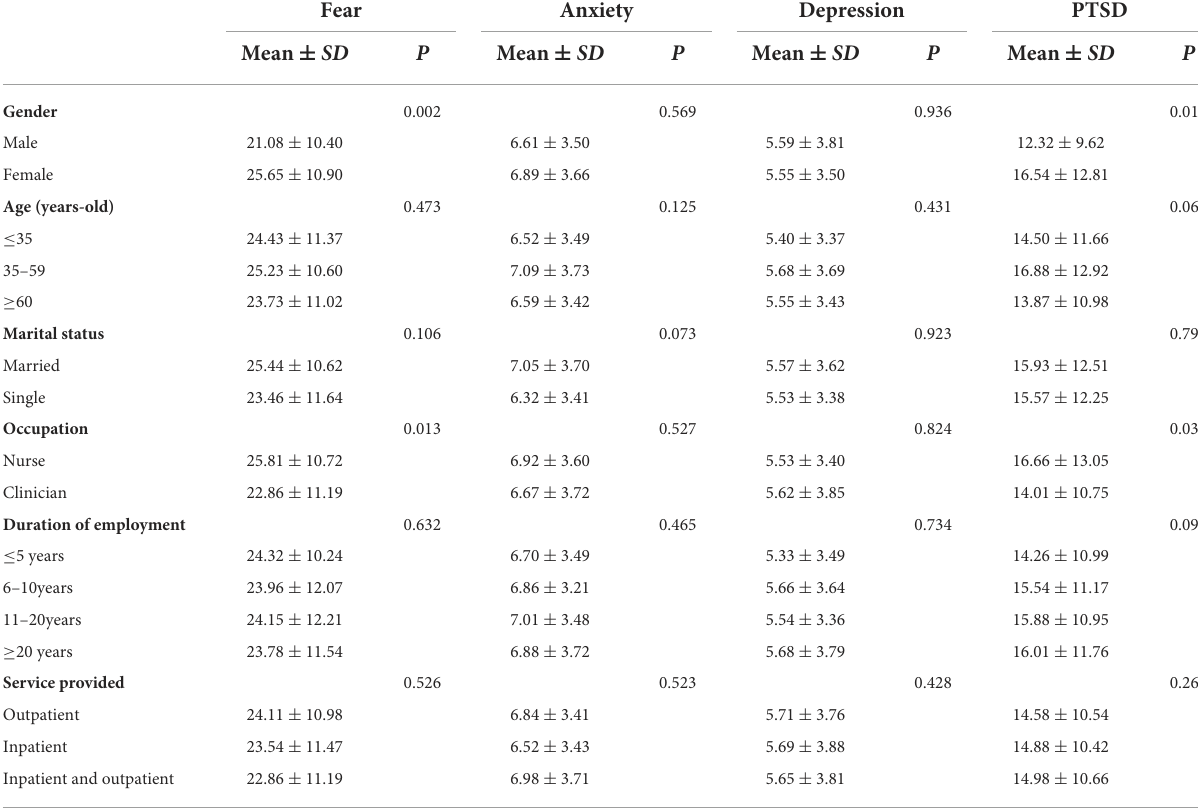
TABLE 3 Association between fear, anxiety, depression, PTSD and clinical characteristics of